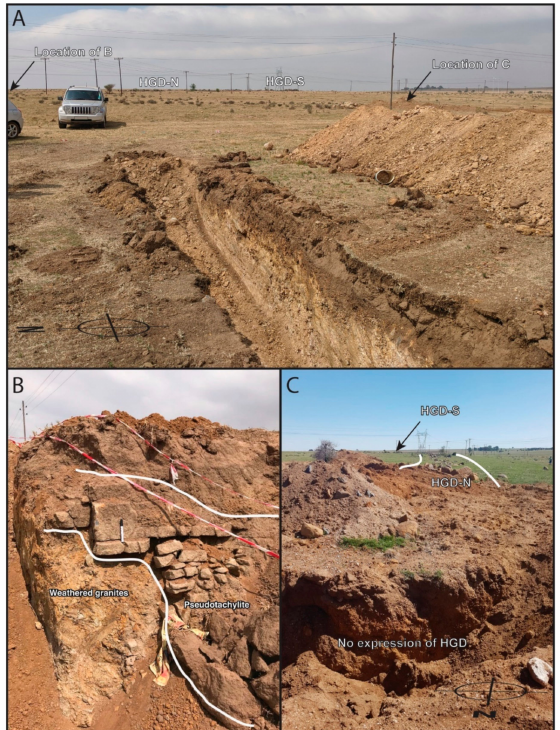
Figure 15. Field photographs showing construction trenching in the vicinity of the Holfontein Granophyre Dike. ( A ) Southeast-facing photograph of a construction trench with marked locations of the figure inset’s B and C and segments HGD-N and HGD-S. ( B ) Photograph of a construction trench northwest of the Holfontein site. Exposed in the trench are weathered granitoid rocks that are highly friable and massive pseudotachylite bodies that remain rigid. Such pseudotachylite bodies are exposed at numerous places within the working trenches. Note the marker (14 cm) for scale. ( C ) A south-facing photograph showing the trench wall, which transected the HGD-N at the location of the former